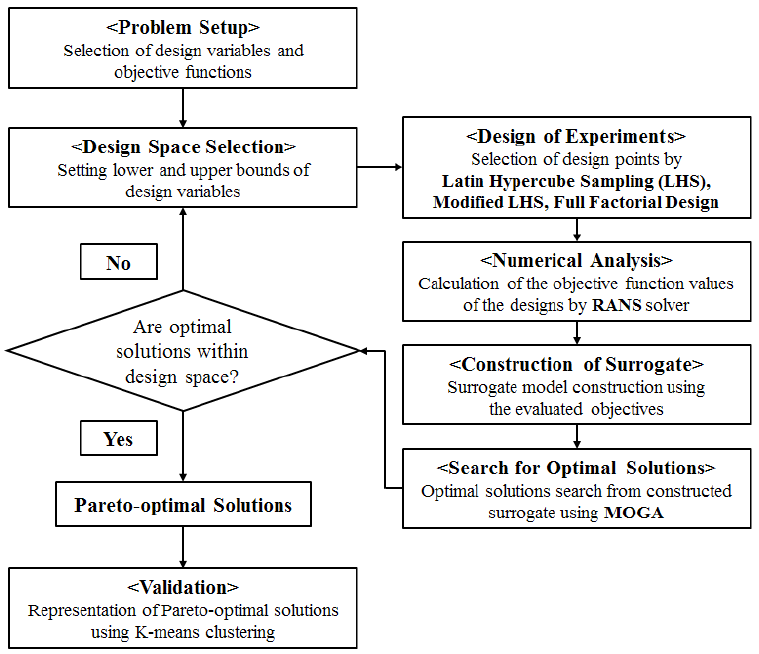
Figure 4. Multi-objective optimization procedure.